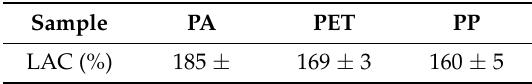
Table 3. LAC results for analyzed textiles.